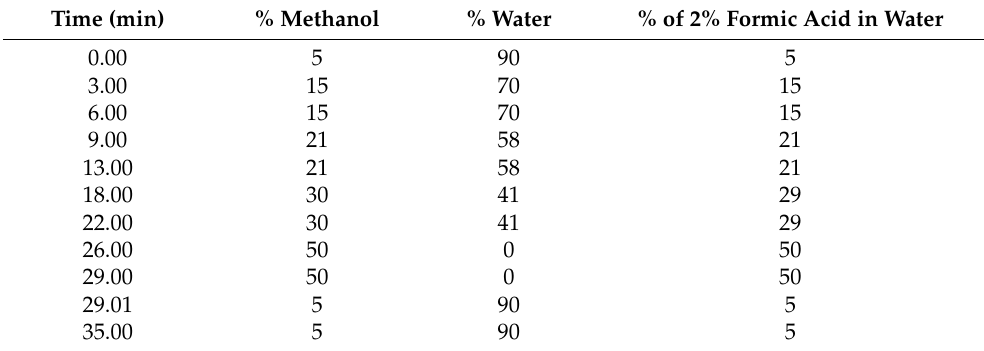
Table 6. LC-MS mobile-phase gradient.